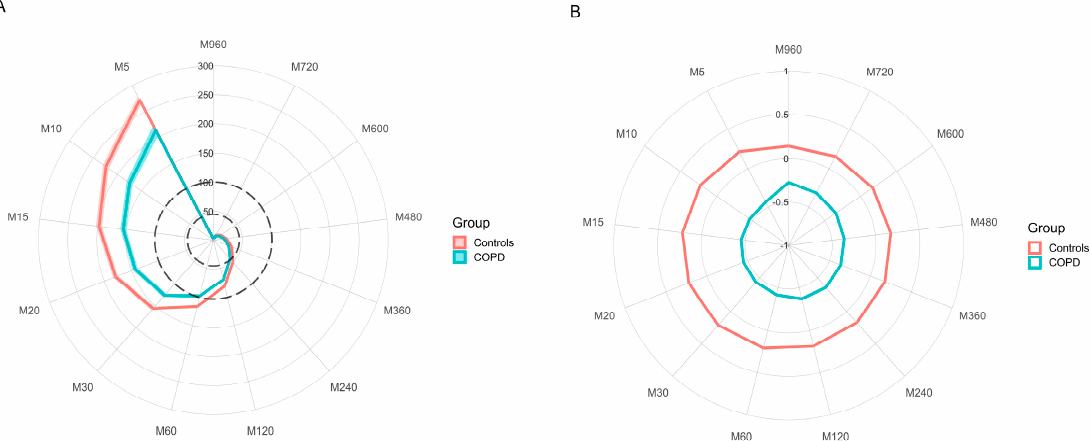
Figure 1. Radar plots representing the MX metrics for both the control and COPD groups. The metrics indicate the minimum level of acceleration (mg) for the most active durations outlined from 5 min to 960 min, e.g., M5 = most active 5 min per day. Coloured thick lines indicate the average value per group and the shaded portions either side of the lines indicates the standard error of the mean (Plot ( A ) only). The black dotted lines (Plot ( A )) represent the threshold in mg for inactivity (44.8 mg [21] and moderate to vigorous physical activity (100.6 mg threshold [20]. Standardised differences in MX values (Plot ( B )) were calculated relative to the mean and standard deviation (SD) of the whole sample.